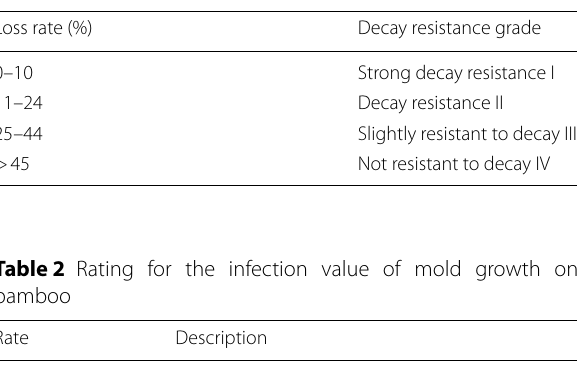
Table 1 Standard method for rating infection value of samples